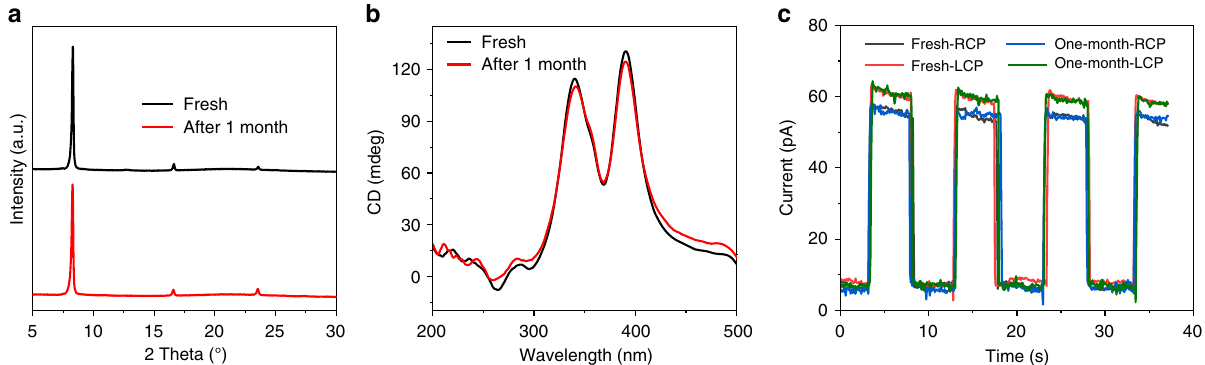
Fig. 5 The ambient stability of ( R - α -PEA)PbI 3 fi lms. a XRD patterns, b CD spectra, and c Photoresponse of fresh and 1-month aged ( S - α -PEA)PbI 3 fi lms under LCP and RCP 395 nm light. ( S - α -PEA)PbI 3 fi lms are stored in a laboratory environment without any